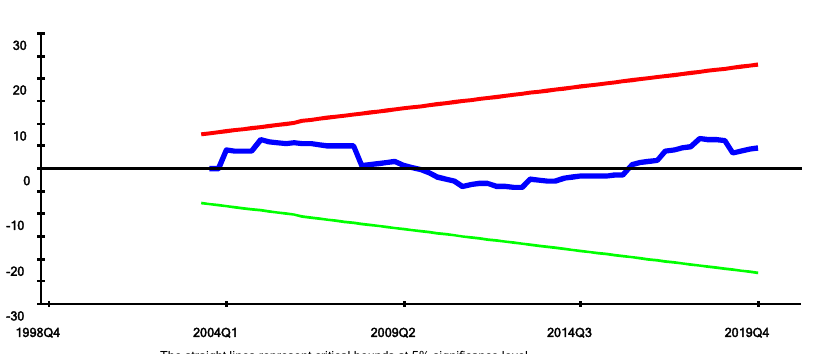
Figure 2. Plot of Cumulative Sum of Recursive Residuals. Source: Author’s Calculation.